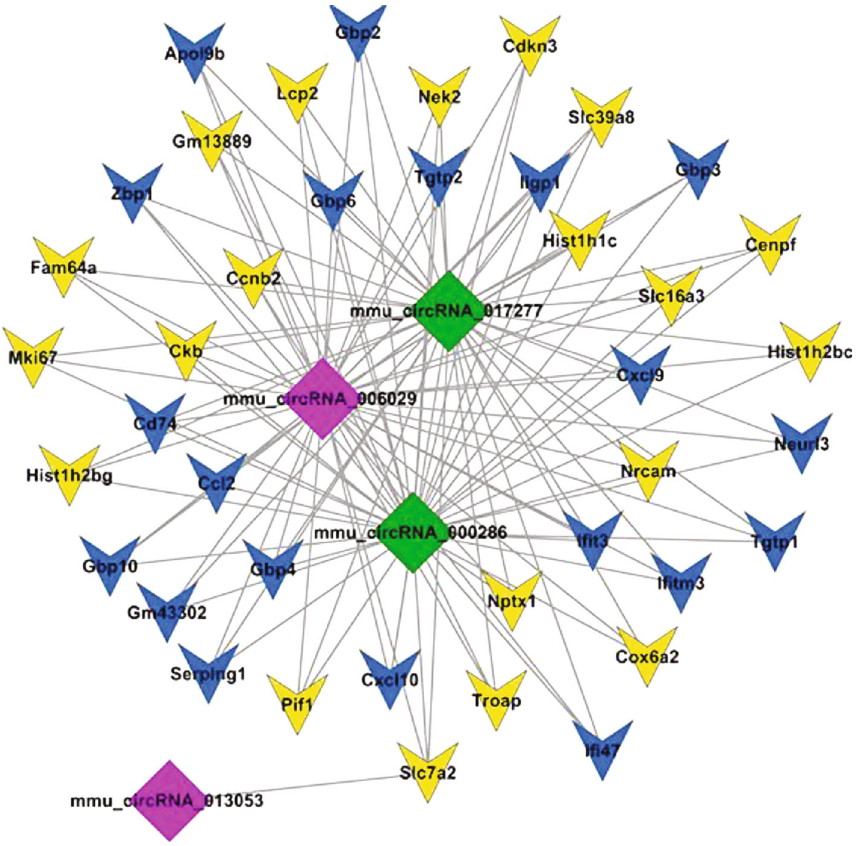
Figure 5: circRNA-mRNA coexpression networks. The four circRNAs (circRNA 006029 and 013053; and circRNA 000286 and 017277) were applied for the coexpression analysis with the top 20 upregulated and downregulated mRNAs. The construction of circRNA-mRNA coexpression network was visualized using Cytoscape. Red diamond represents upregulated circRNA. Green diamond represents downregulated circRNA. Blue VEE represents upregulated mRNA. Yellow VEE represents downregulated